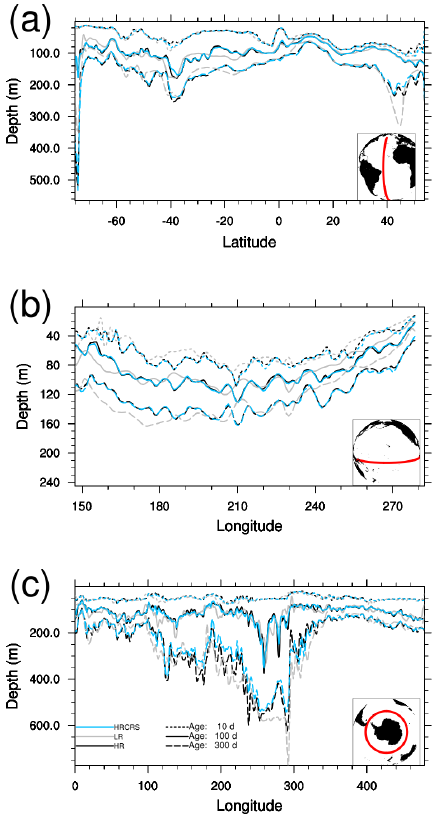
Figure 11. Atlantic (a) , Pacific (b) and ACC (c) sections of age tracers after 1 year of simulation for HR (black), LR (grey) and HRCRS (blue) configurations. The age value is 10d (dotted line), 100d (solid line) and 300d (dashed